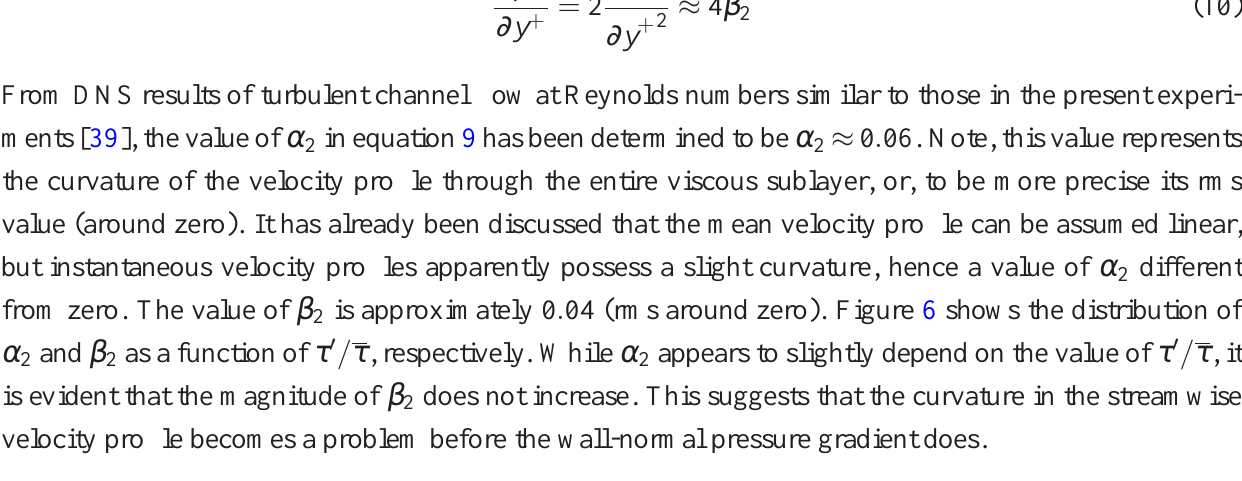
Figure 6. ( a ) Curvature coefficient a file u + ( y + ) . ( b ) Curvature coefficient b normal